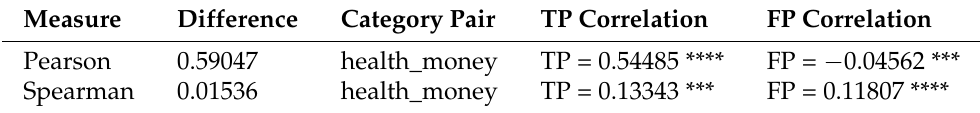
Table 35. Health and Money in Low.